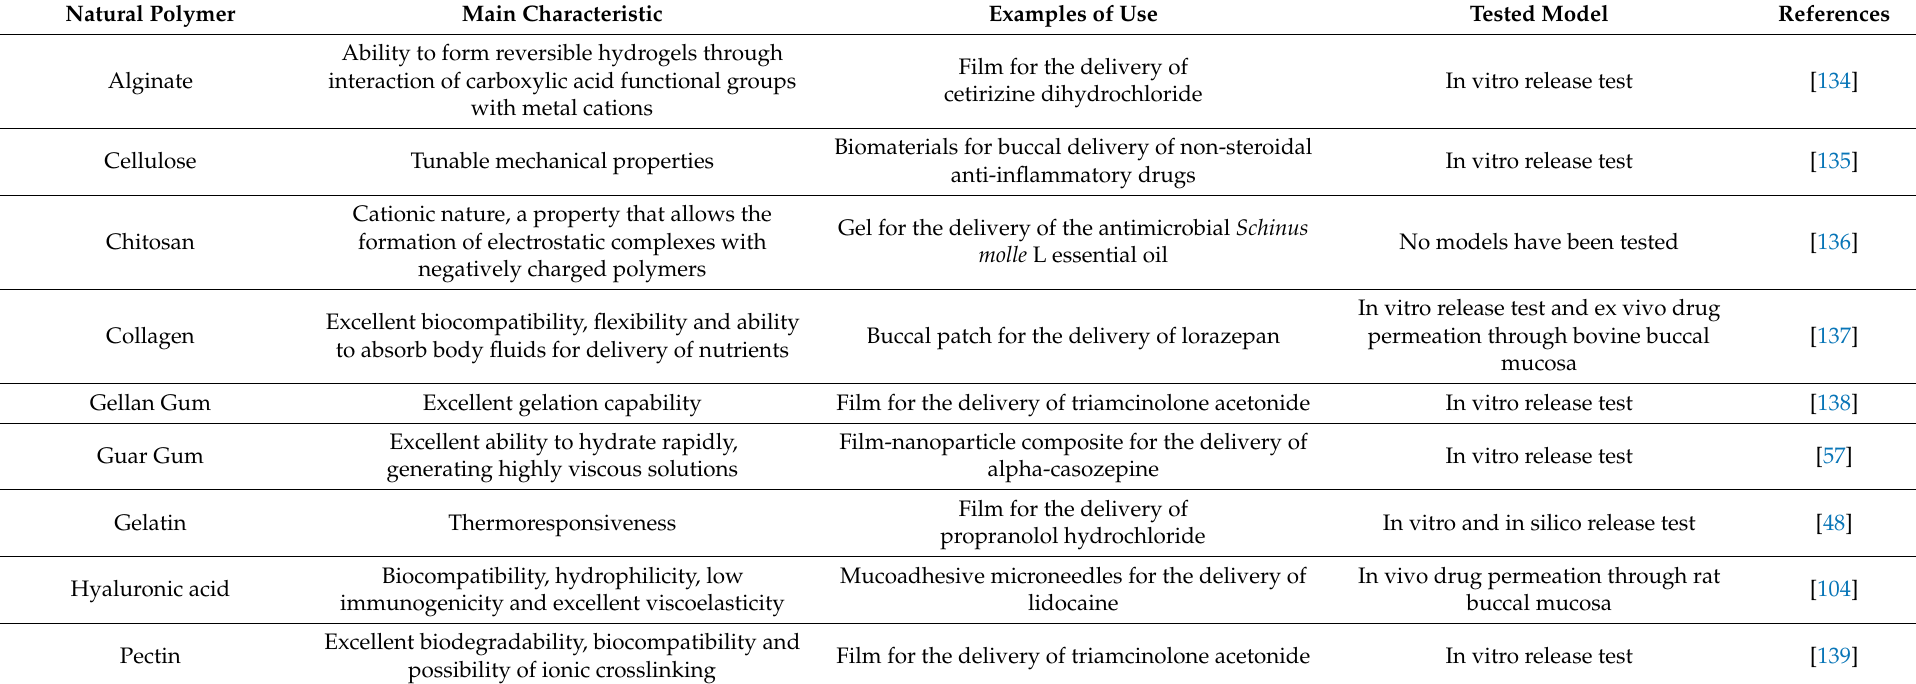
Table 2. Main natural polymers used to manufacture oral drug delivery biomaterials and examples of their